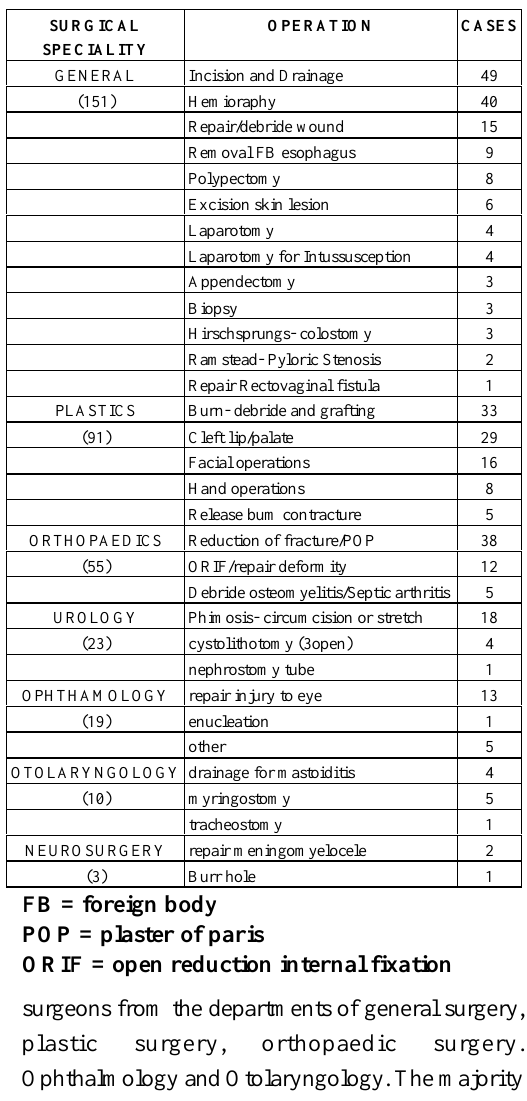
table I. In the <1 year age category there were 20 patients <4 months, 17 patients 4-6 months, and 20 patients 6 months to 1 year.